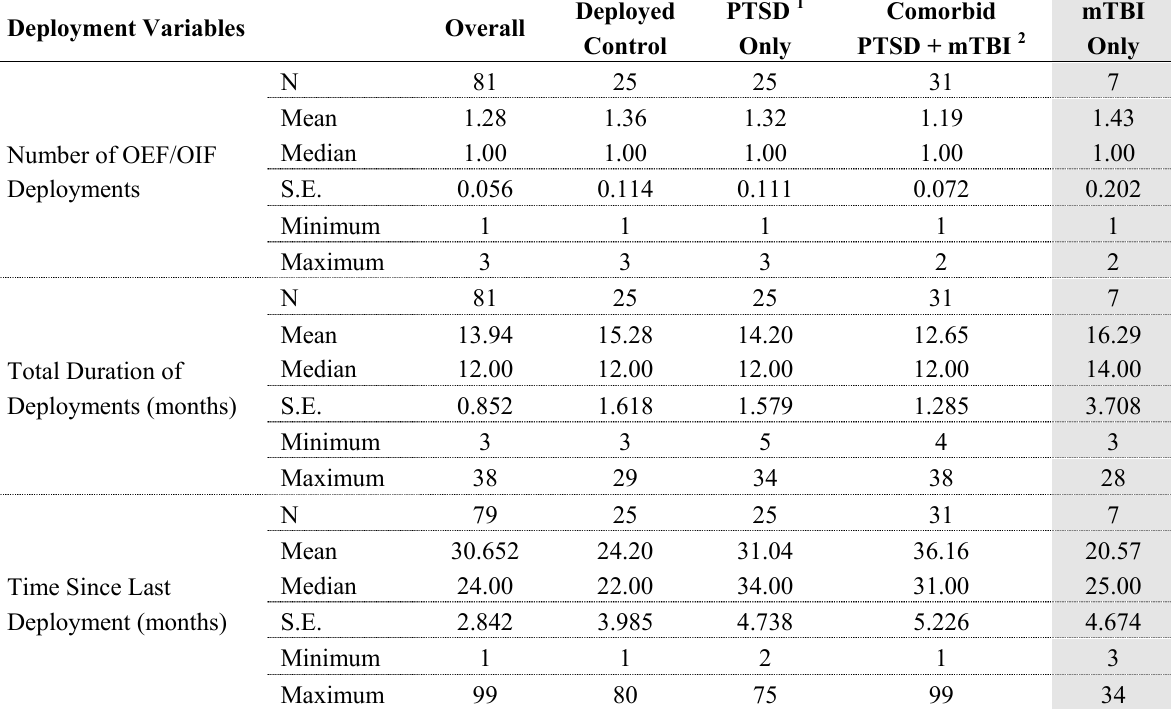
Table 3. Descriptive statistics for